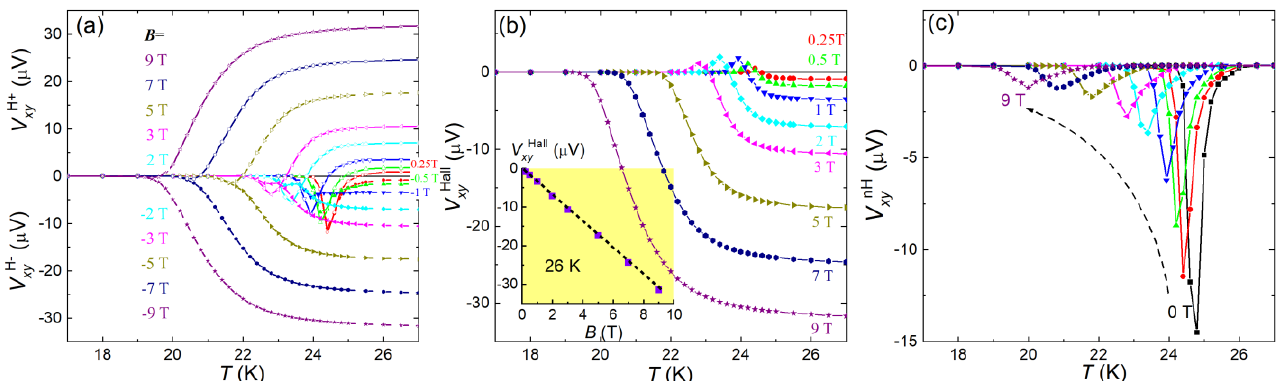
Figure 4. ( a ) Transverse voltages V H + xy and V H − xy at different directions of external magnetic fields as functions of temperature for the Ba(Fe 0.914 Co 0.086 ) 2 As 2 crystals. ( b ) and ( c ) plot the temperature dependence of Hall and non-Hall transverse voltages, respectively. See the experimental method in the text for details.